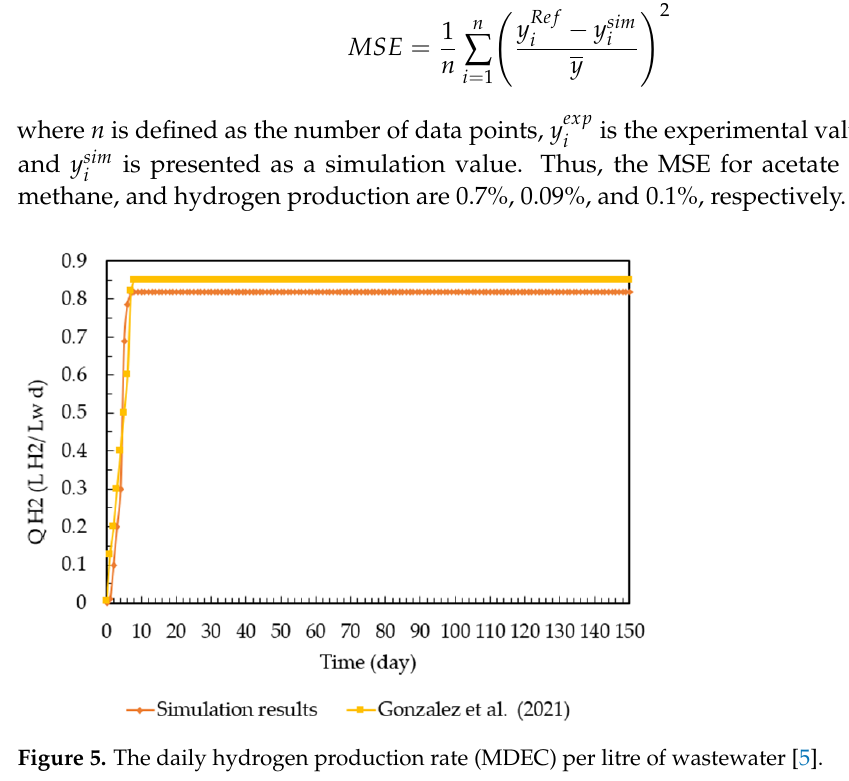
Figure 4. The daily methane production rate (MFC) per litre of wastewater [20].